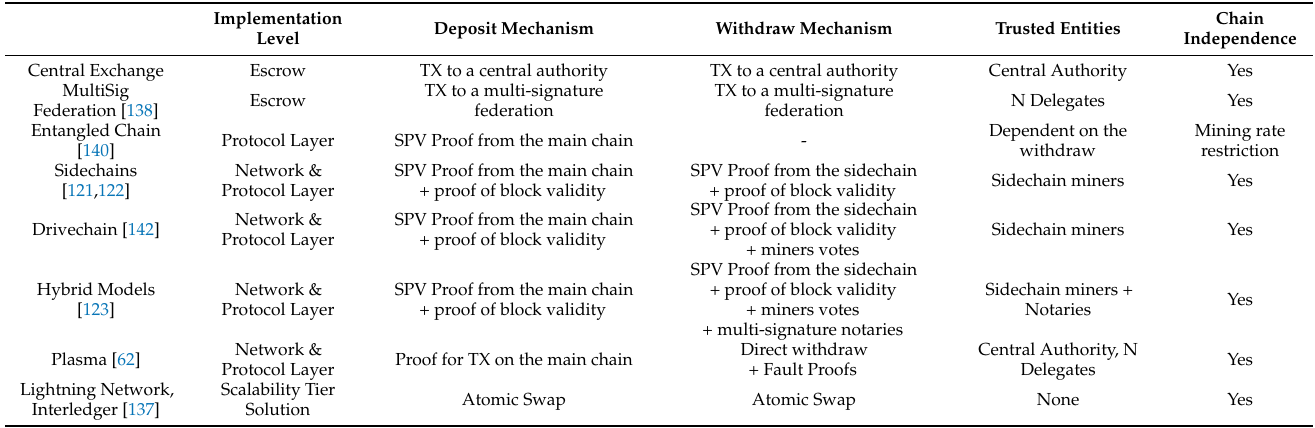
Table 8. Ledger to Ledger interoperability